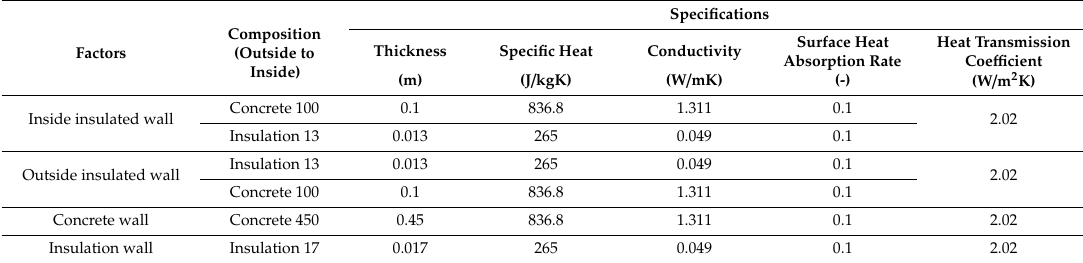
Table 6. Material and composition of wall.